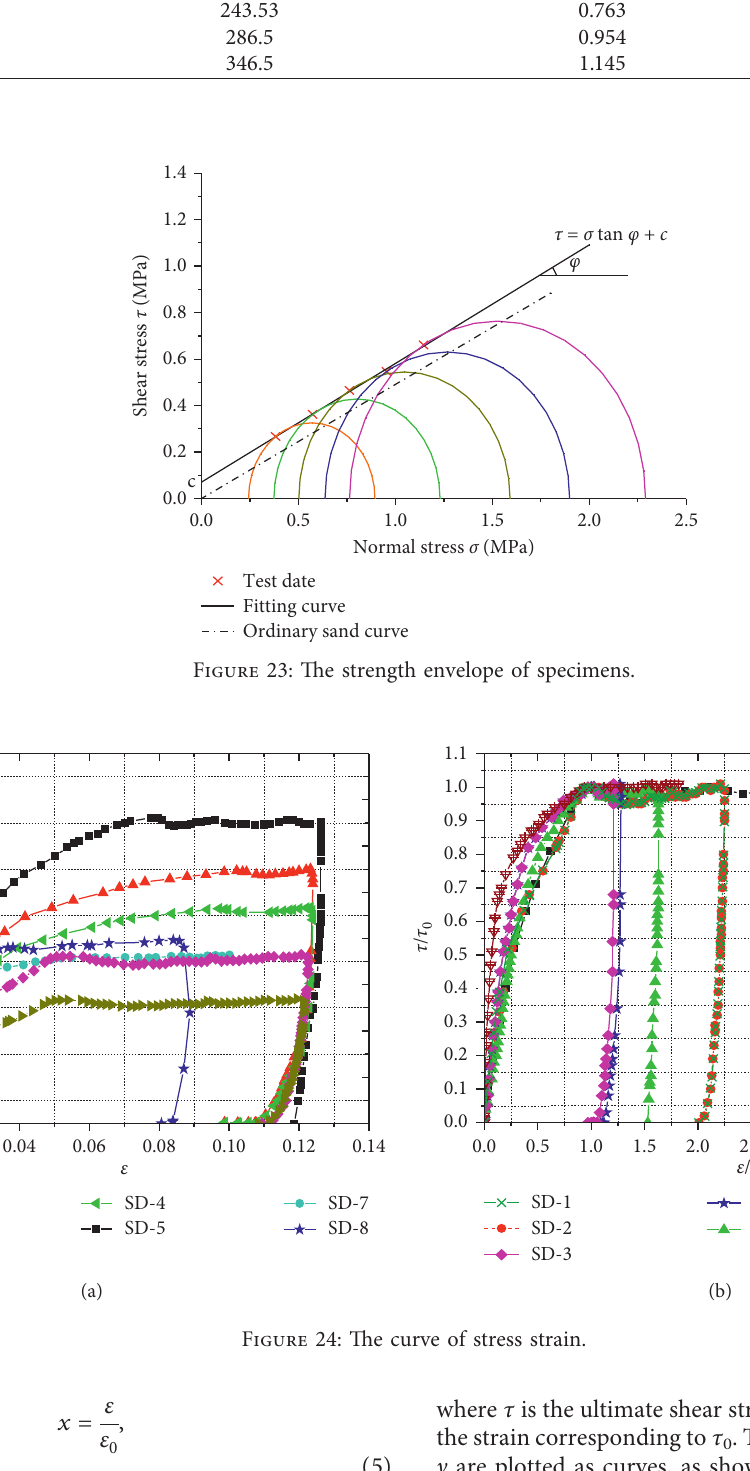
Figure 24: The curve of stress strain.